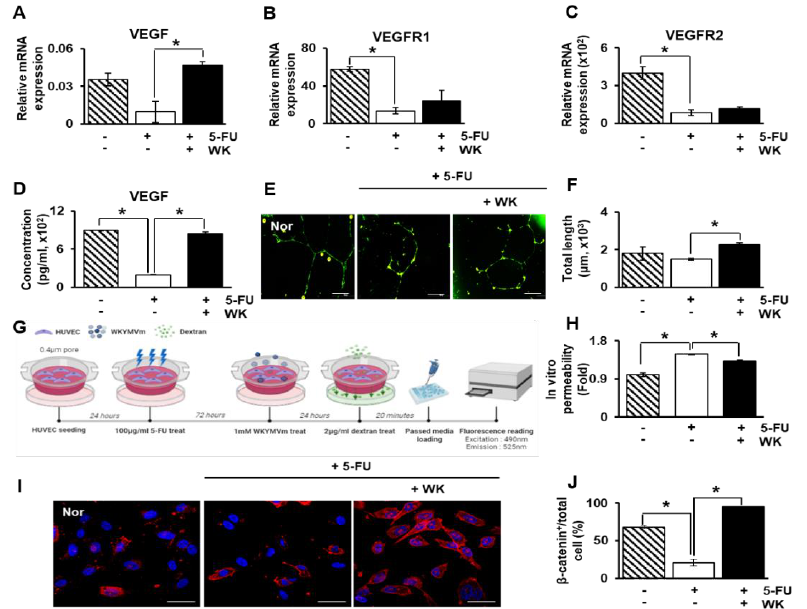
Figure 4. WKYMVm exerts angiogenic effects in human umbilical vein endothelial cells (HUVECs). The mRNA levels of VEGF (A) , VEGFR1 (B) and VEGFR2 (C) in HUVECs pretreated with 5-FU and treated with WKYMVm were analyzed by qRT-PCR. (D) VEGF secretion by HUVECs was measured by ELISA. (E) Tube formation assay. Scale bar: 20 μm. (F) Quantification of the tube length in micrometers. (G) Experimental scheme of the dextran permeability assay. (H) Quantification of permeability was determined by the fluorescence intensity in the lower chamber. (I) Immunofluorescence analysis of active β-catenin in HUVECs. (J) Quantification of the percentage of nuclear β-catenin. Mean ± SD ( n =3 per group), * p < 0.05; t-test. Nor, normal control group; NTx, untreated BDL group; +WK, WKYMVm-treated BDL group.